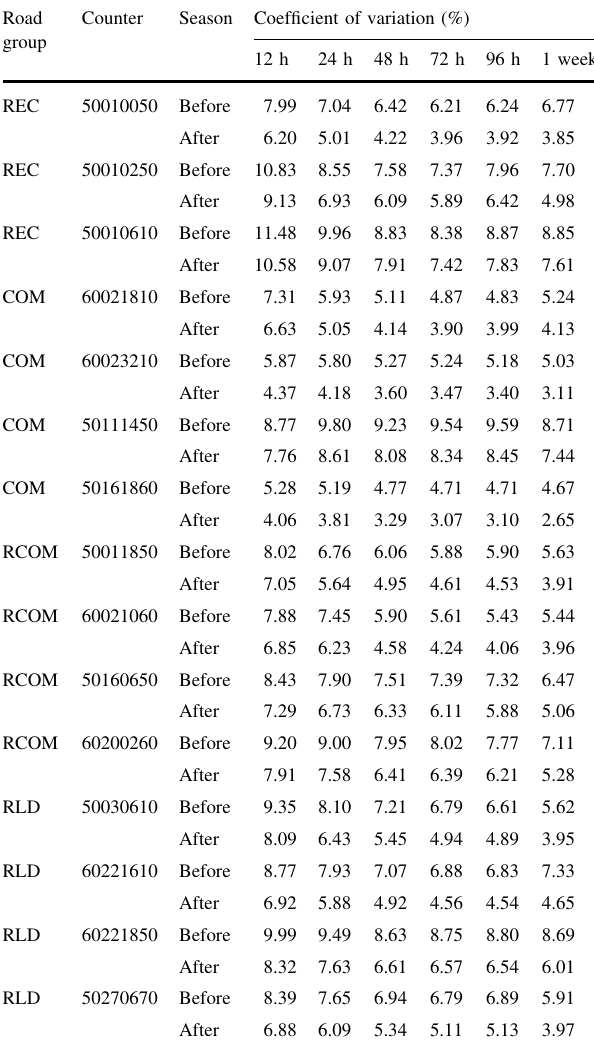
Table 6 CV values for winter SDCs before and after the application of adjustment factors Road